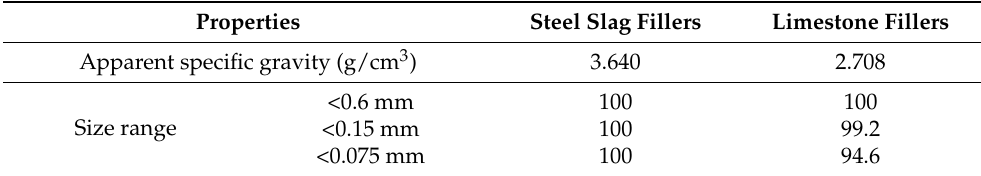
Table 2. Properties of steel slag fillers and limestone